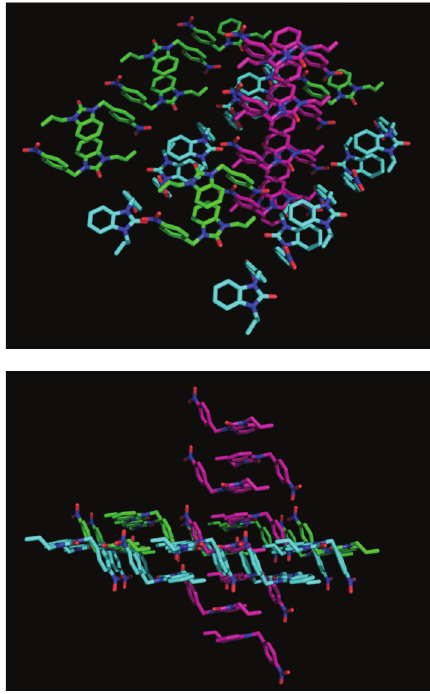
Figure 9: Observed arrays (based on nitrobenzene–nitrobenzene interactions) highlighted in green and cyan in the bc plane and in the a direction in magenta (formed by 1H-benzo[d]imidazol-2(3H)- one–1H-benzo[d]imidazol-2(3H)-on 𝜋 – 𝜋 interactions).